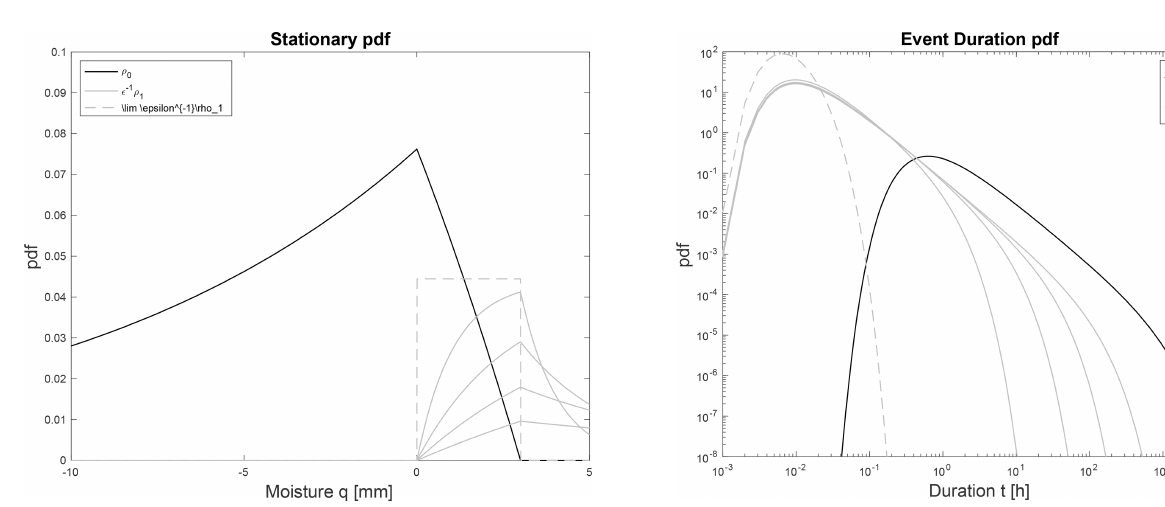
Figure 4. Event duration pdfs for dry events ( ρ 0 t black line) and rain events ( ρ 1 t gray lines) for (cid:15) = 1 , 0 . 5 , 0 . 25 , and 0 . 1. The dashed line is for (cid:15) = 0 .